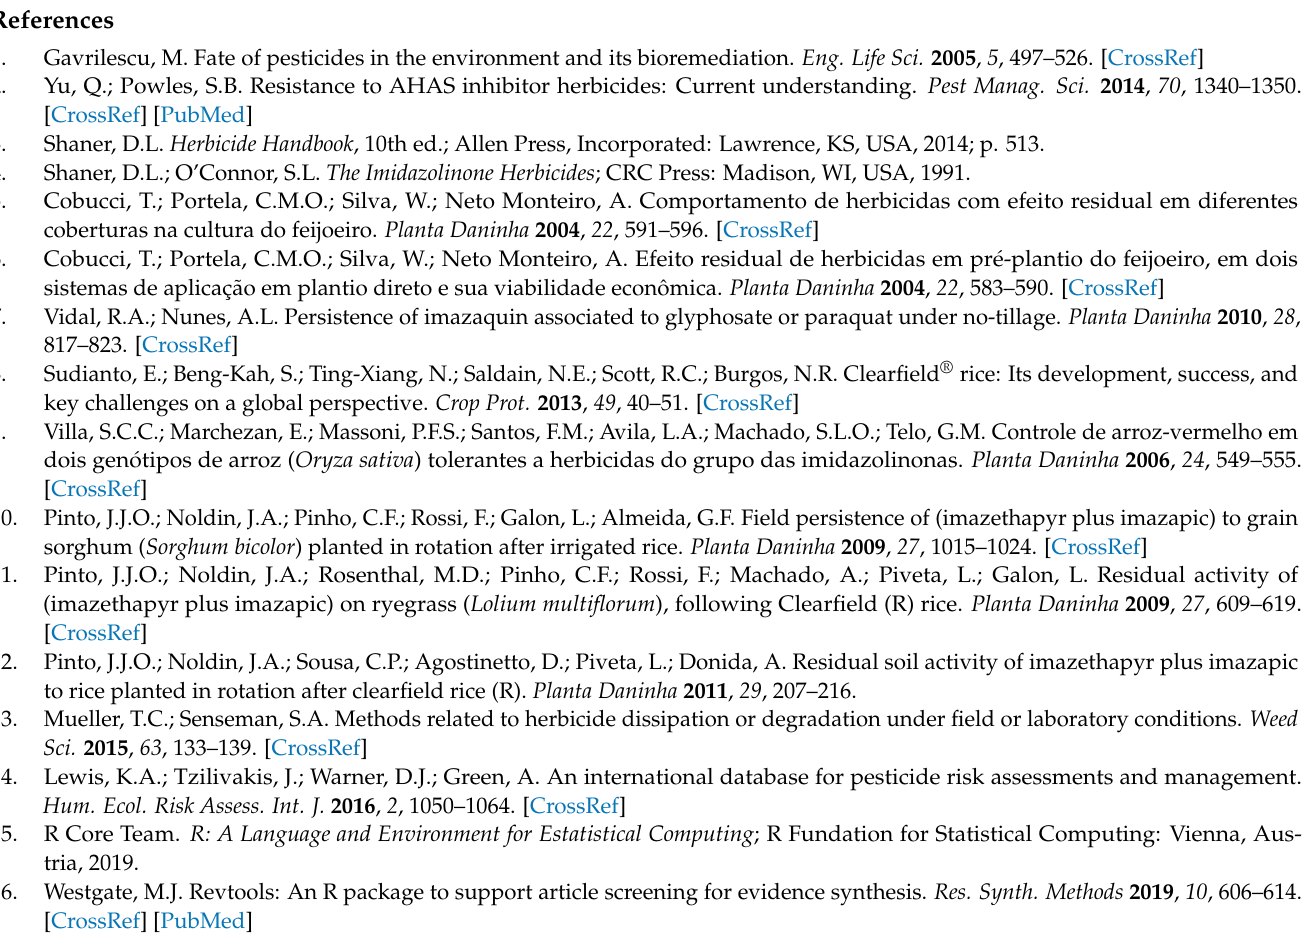
Figure S2: Ordinary axis graph showing the selection of included/excluded records by topic. Topics were arbitrarily classified as environmental dynamics (1, 7 and 8), weed management (4 and 10), quantification methodologies (3), omics (5 and 9), and generic (2 and 6). Figure S3: Color guides of the bibliographic records of the data used throughout the text., and